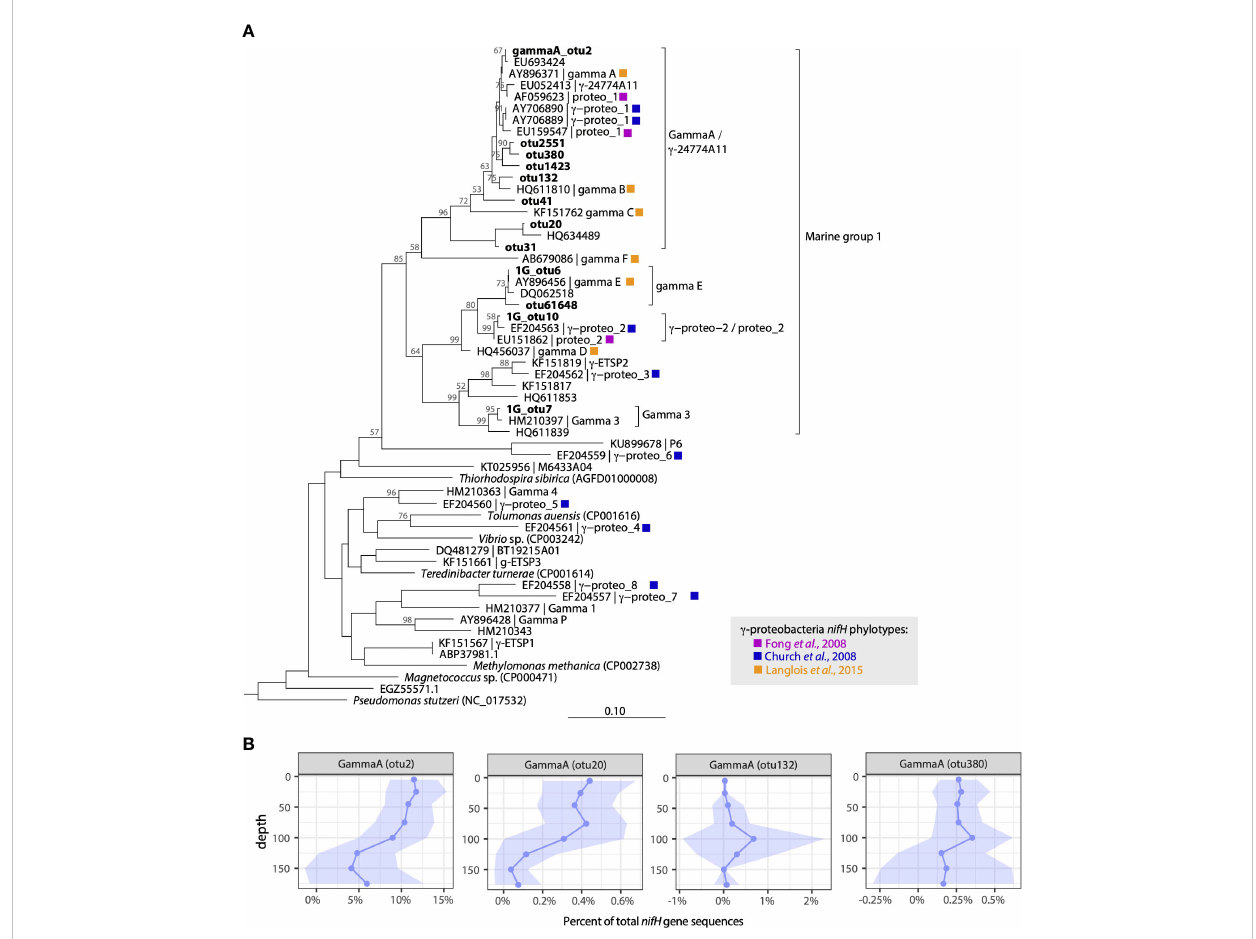
FIGURE 2 Diverse g -proteobacterial diazotrophs inhabit waters at Stn. ALOHA. (A) Neighbor-joining nucleotide tree of g -proteobacterial OTUs along with representative sequences from prior studies in the North Paci fi c. Cluster designations follow those de fi ned in Langlois et al. (2015) or re fl ect naming conventions from Fong et al. (2008) and Church et al. (2008). (B) Depth pro fi les of selected gamma A OTUs plotted as a percent of total nifH gene sequences in the rare fi ed dataset. Solid lines represent mean values, shading represents ± 1 standard